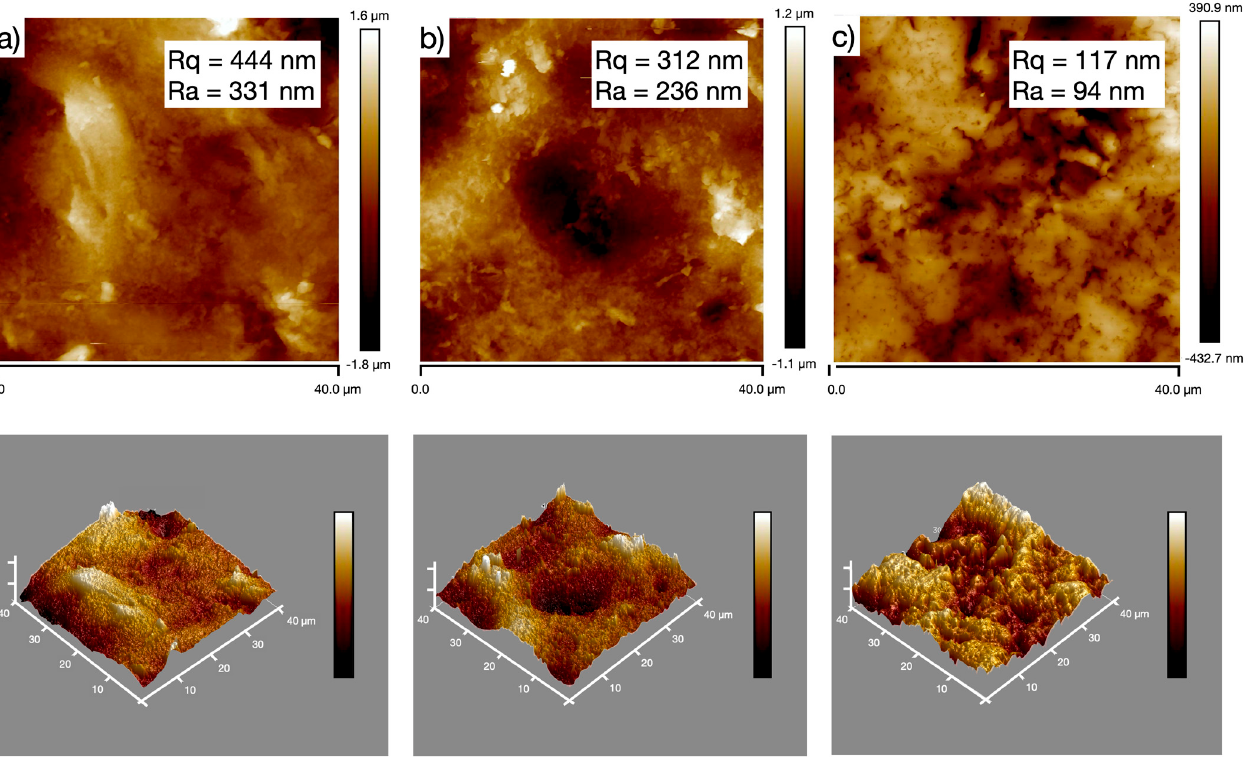
Figure 7. AFM images of the surface of: ( a ) NC, ( b ) CRC cured at 40 °C, and ( c ) CRC cured at 25 °C.